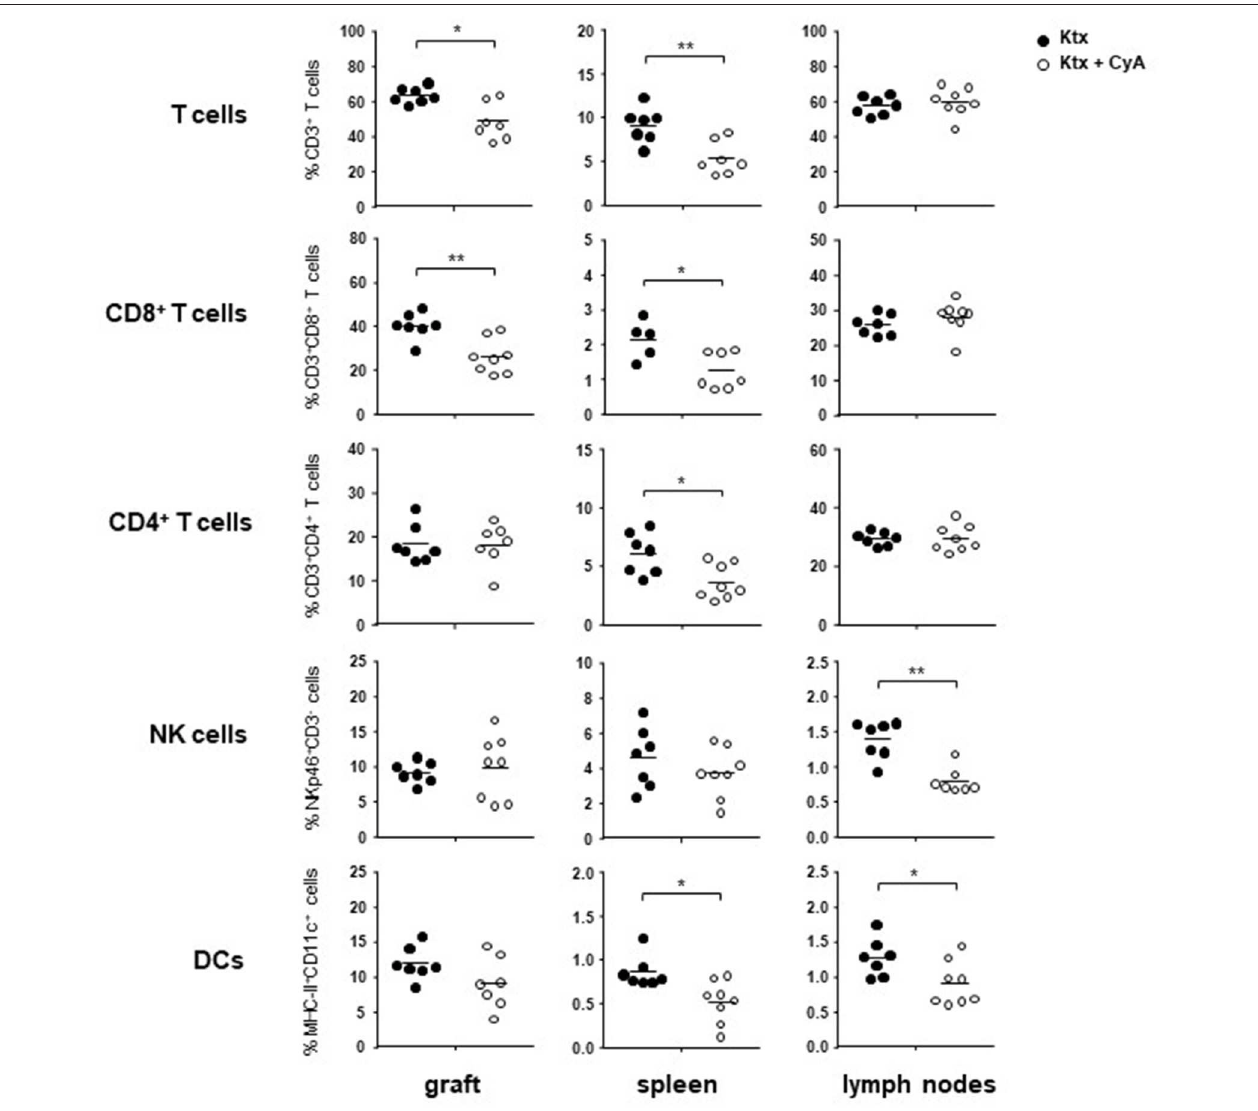
FIGURE 1 | Administration of CyA leads to modulation of intragraft lymphocyte frequencies. After CyA administration, C57BL/6 recipient mice of BALB/c kidneys showed on POD7 significantly decreased frequencies of T cells in the allograft as well as in the spleen as compared with untreated recipients. NK cell frequencies were solely affected as a consequence of CyA treatment in the lymph nodes, whereas DC frequencies were significantly decreased in both spleen and lymph nodes, but not in the graft. Data are presented as mean of n = 7–8 animals/group. Cells were pre-gated on live CD45 + events. Statistically significant differences between naïve and CyA-treated animals were tested with the Mann-Whitney U -test; * p < 0.05, ** p <